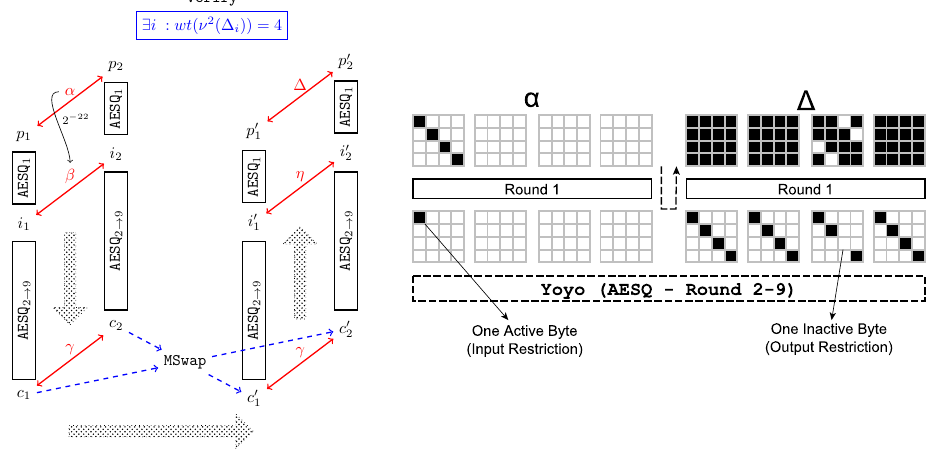
Figure 8: Probabilistic 9-round Yoyo distinguisher. A configuration of ( α, ∆) is shown. Now, the final probability Pr random permutation R is given by p 0 = 2 − 26 . 08 and p = 16 × 2 − 32 × ( 255 respectively, giving us a success rate of 71% at the data complexity of 2 26 . 08